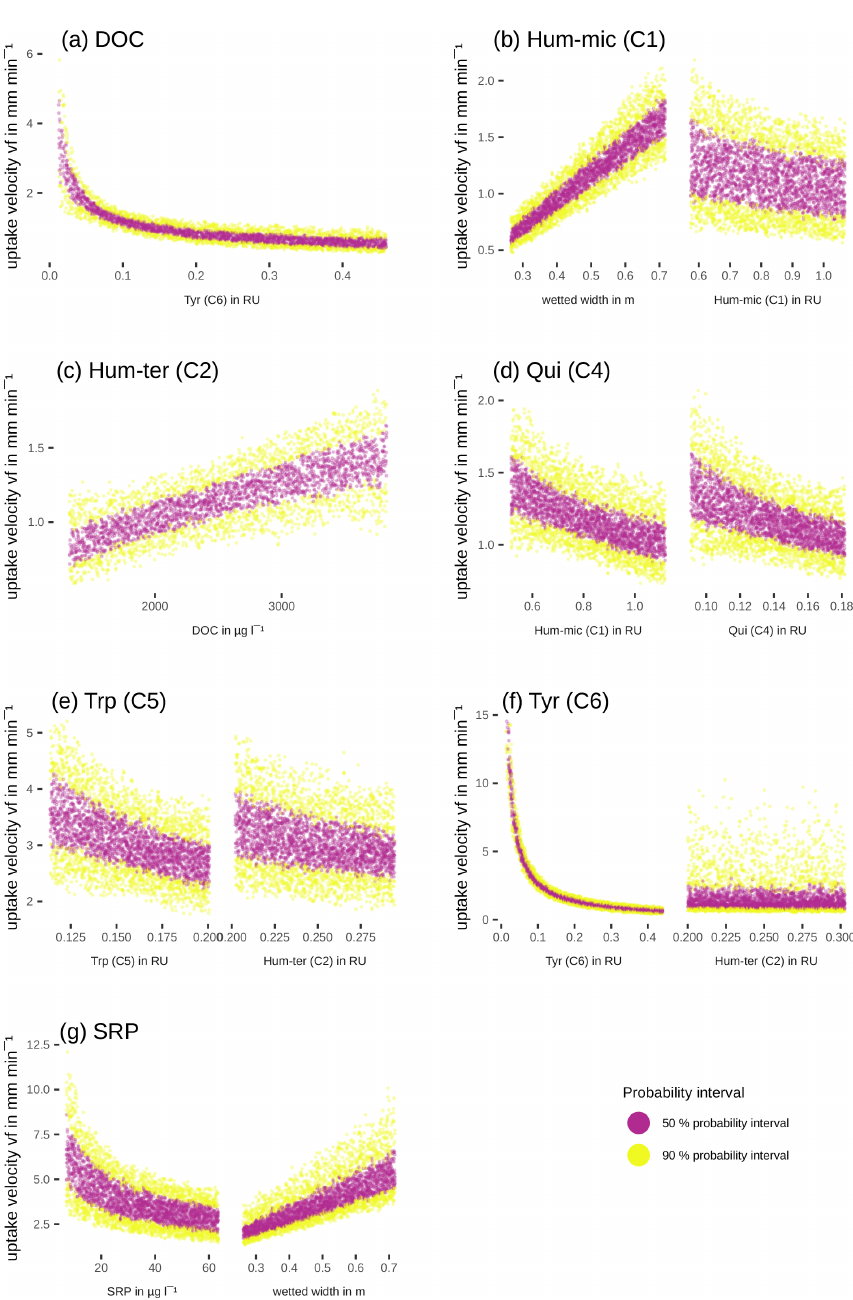
Figure 7. Simulated change of uptake velocity v f with variation of one variable using the fitted models from Table 6. The colours show the 50% (violet) and the 90% (yellow) probability